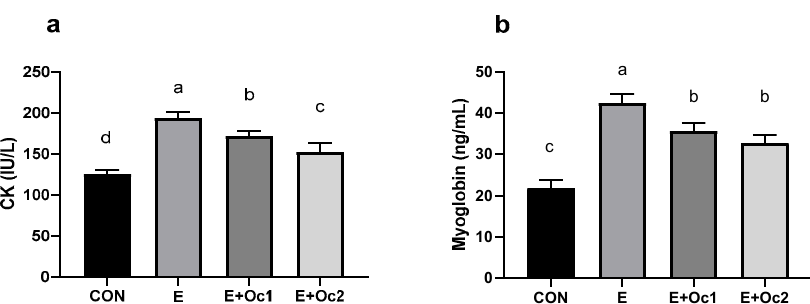
Figure 4. Bar charts displaying the mean and standard error for serum creatine kinase ( a ) and myoglobin( b )followingthe6-weekmotorizedrodenttreadmillexerciseprotocoldescribedinSection3.1. Conditions are: Control (CON), Exercise (E), Exercise + Oceanix 1 (2.55 mg / kg / day, (E + Oc1)), and